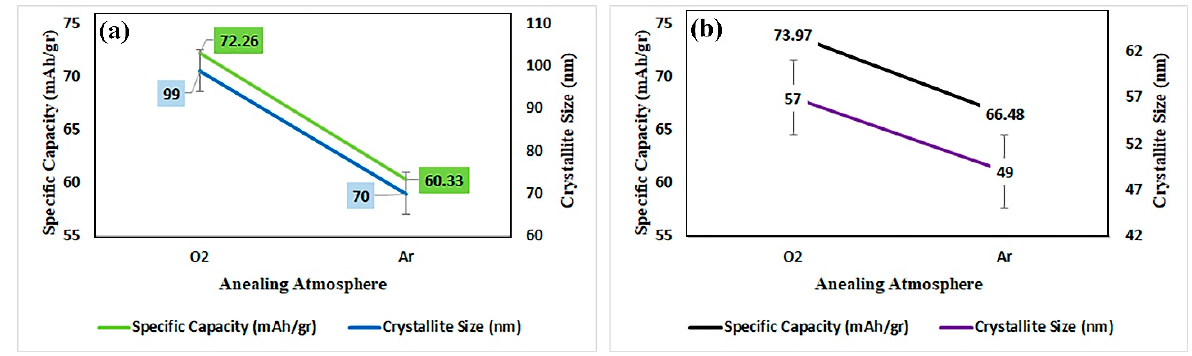
Figure 3. Comparison of the effect of annealing atmosphere on the crystal grain sizes and the specific capacity obtained X-ray diffraction data using the Williamson–Hall equation ( a ) TiNb 2 O 7 , ( b ) Ti 2 Nb 10 O 29.